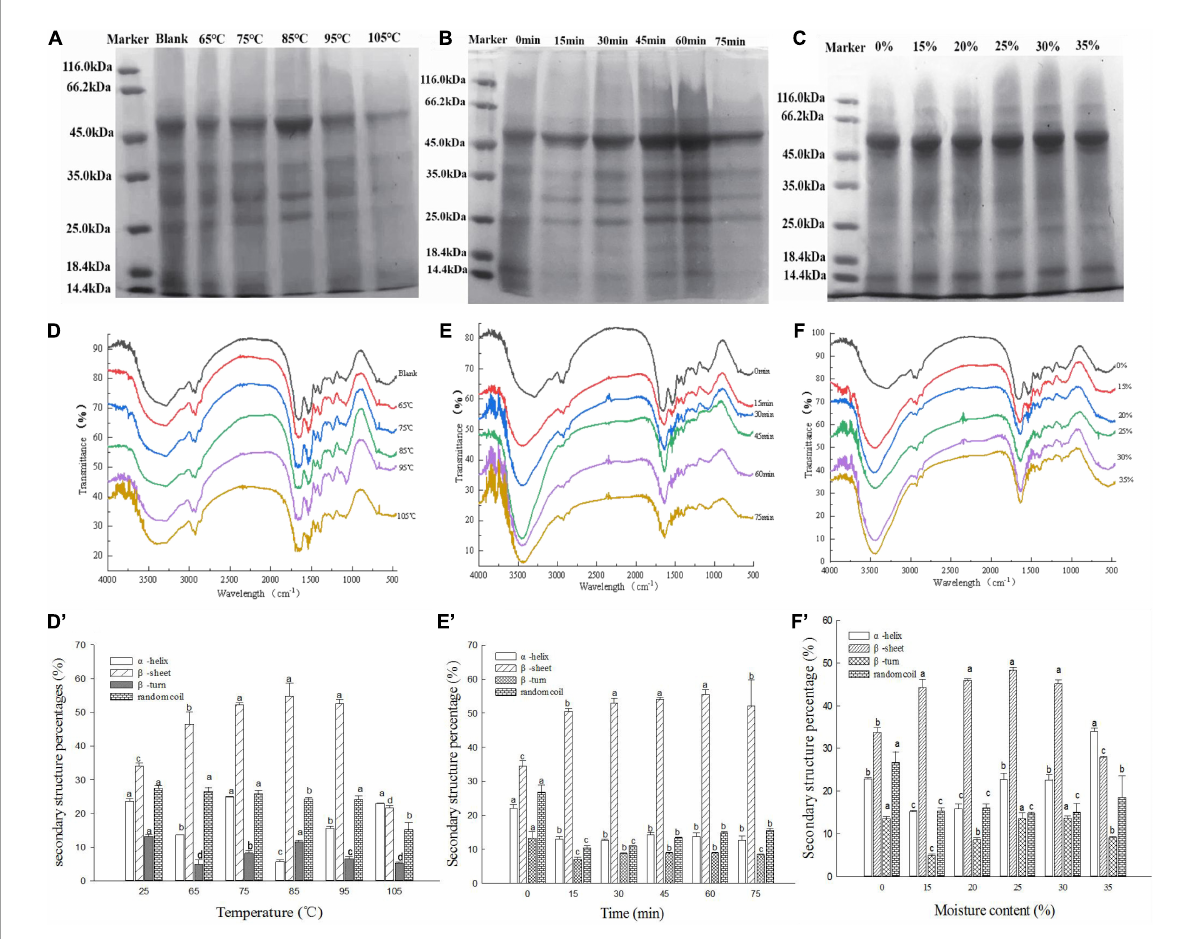
FIGURE2 Changes in the structure of the hydrothermally treated MBPs at different controlled temperatures (25, 65, 75, 85, 95, and 105 ◦ C), processing times (0, 15, 30, 45, 60, and 75 min) and moisture contents (0, 15, 20, 25, 30, and 35%). (A–C) SDS–PAGE of the MBPs under the different treatment conditions, respectively. (D–F) FTIR spectra of the MBPs under the different treatment conditions, respectively. (D’–F’) Secondary structure percentages of the MBPs under different treatment conditions based on FTIR analysis. The letters a–d indicate significant differences between the